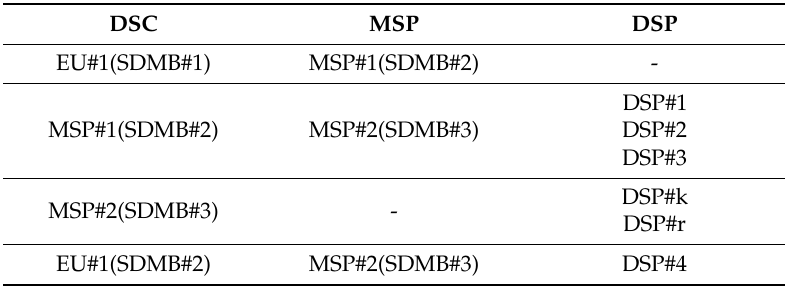
Figure 5. Stakeholder’s Communication Model. Table 1. Roles of Stakeholders.